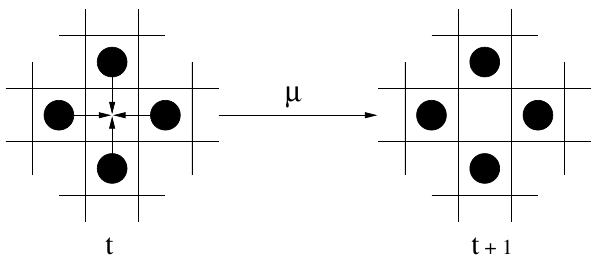
Figure 6 Refused movement due to the friction parameter